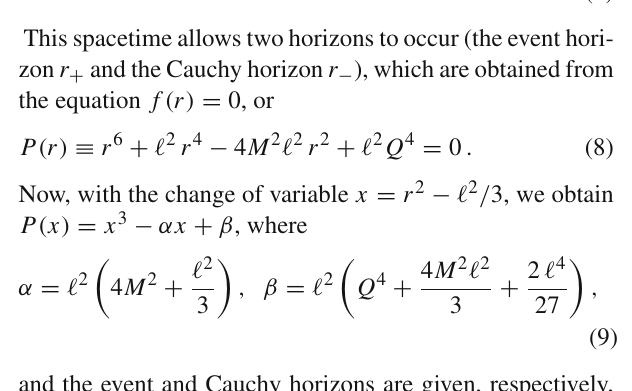
Fig. 1 The behavior of the metric function f ( r ) , with M = 1, (cid:4) = 10, for different values of Q